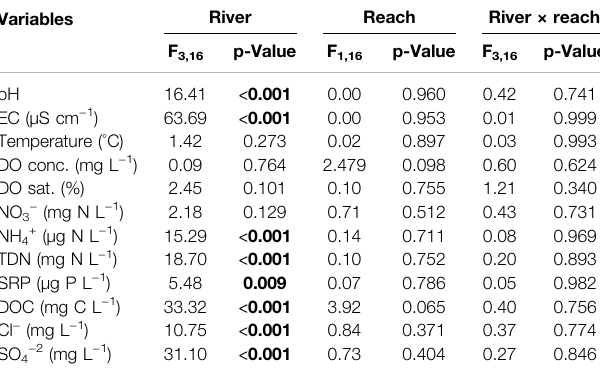
TABLE 2 | Results of linear models testing for the effect of river, reach, and their interaction on water quality variables ( n = 24). p-Values wereobtained by two- way ANOVA test. EC = Electrical conductivity, DO = dissolved oxygen, NO 3 − = nitrates, NH 4+ = ammonium, TDN = total dissolved nitrogen, SRP = soluble reactive phosphorus, DOC = dissolved organic carbon, Cl − = chloride and SO 4 − 2 = sulfate. F-values are shown in the table and the degrees of freedom indicated at the top of the table are the same for all the tests. Signi fi cant p-values are shown in